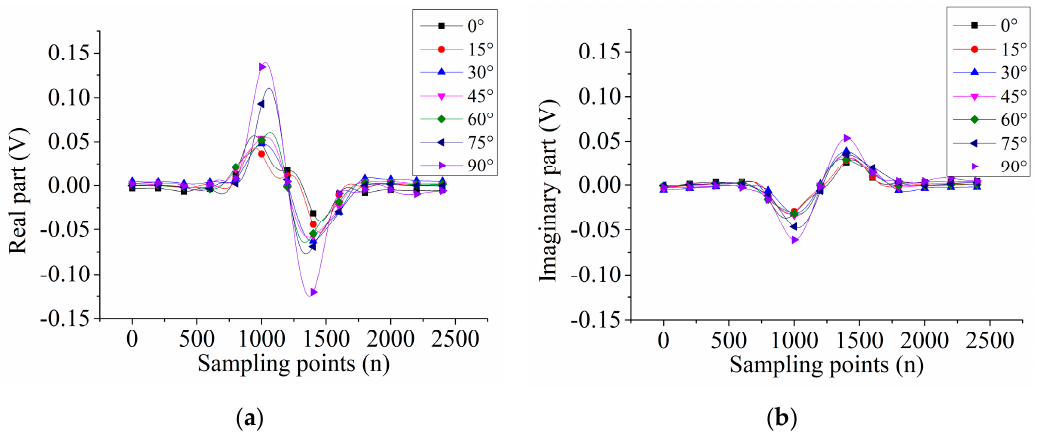
Figure 6. The signal output of 5-mm length defect by probe A: ( a ) real part, ( b ) imaginary part.